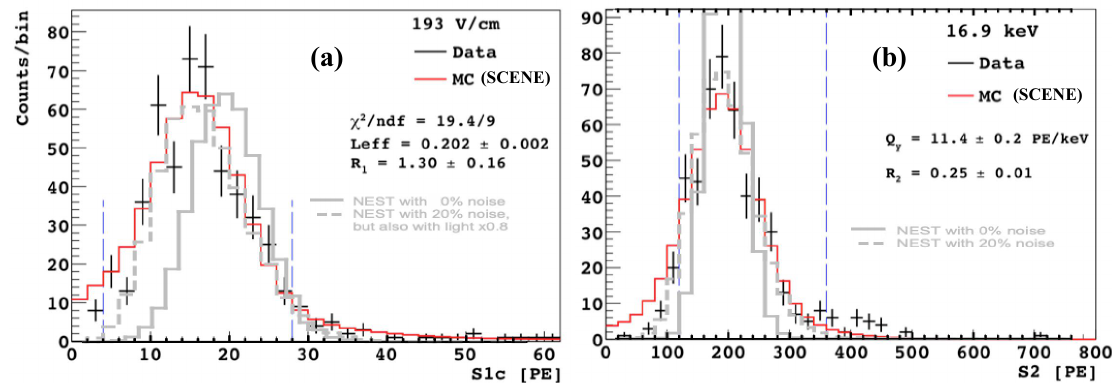
Figure 11. ( a ) S1 peak and ( b ) S2 peak for 16.9 keV NR in LAr from Cao et al. [200]. Data are in black with errors, with original MC in red (fit borders for it as vertical blue lines) and NEST overlaid in gray over original paper plots: defaults solid, while altered to match data in dash. Large noise levels needed in NEST are comparable to those assumed by SCENE ( R 1 and R 2 in legends imply S1 30%, S2